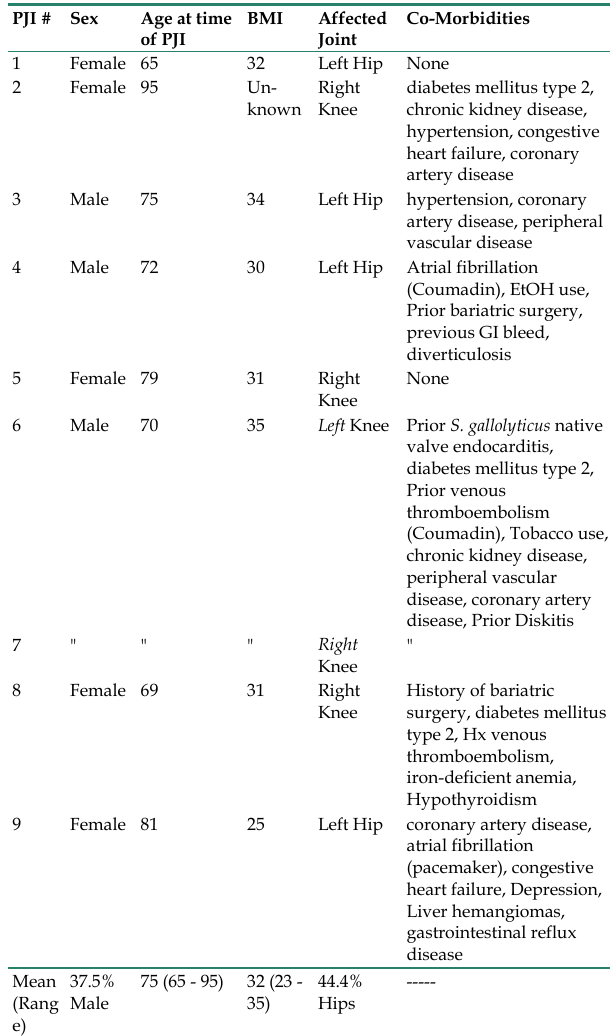
Table 1. Demographic data related to 9 cases of SBG